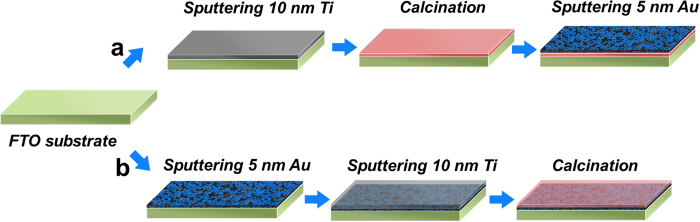
The fabrication procedure of Au/TiO2
bilayer structures on FTO substrates.(a) FTO/TiO2/Au and (b) FTO/Au/TiO2 photoelectrodes.